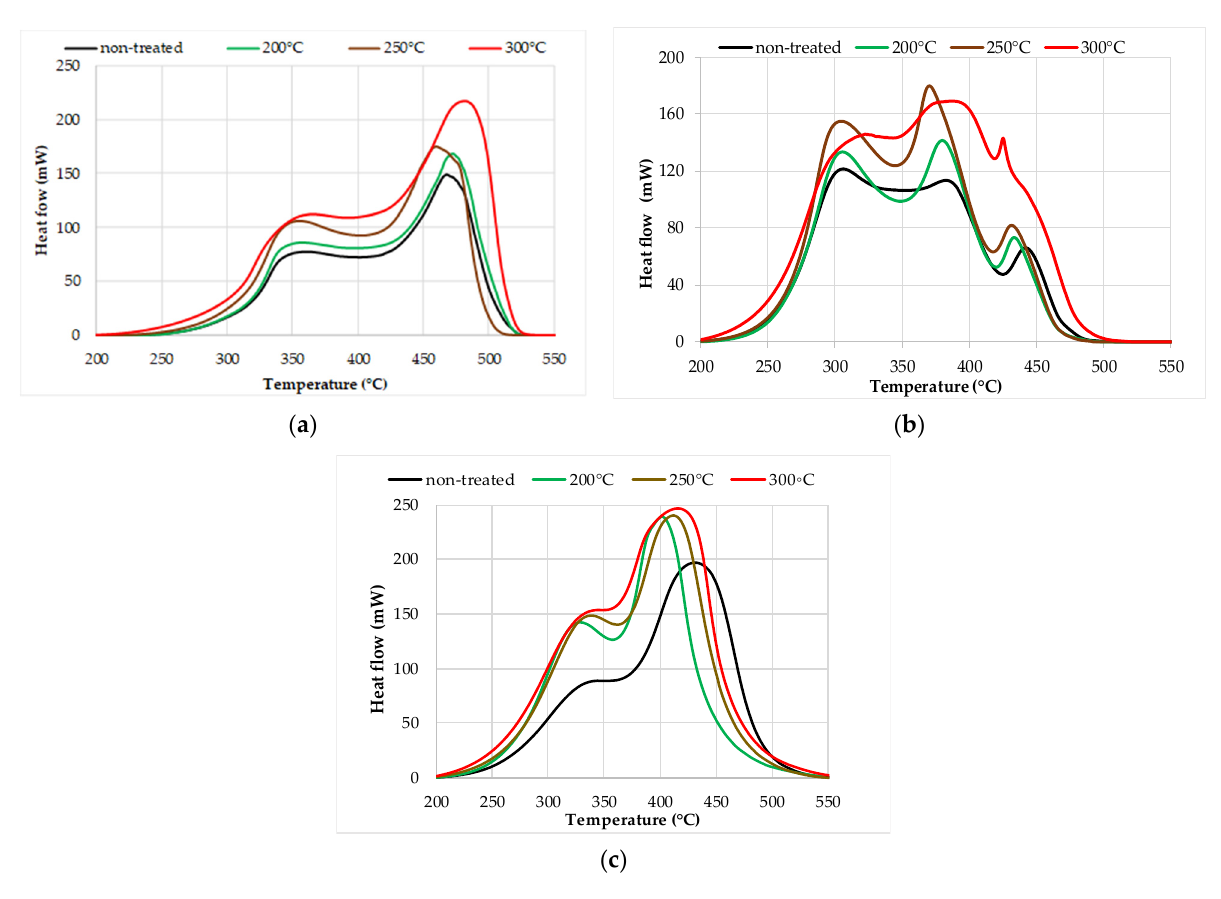
Figure 9. DSC curves of the non-treated biomass and the solid fractions that were obtained by its MW-assisted torrefaction at different temperature: ( a ) softwood, ( b ) wheat straw, and ( c ) peat.